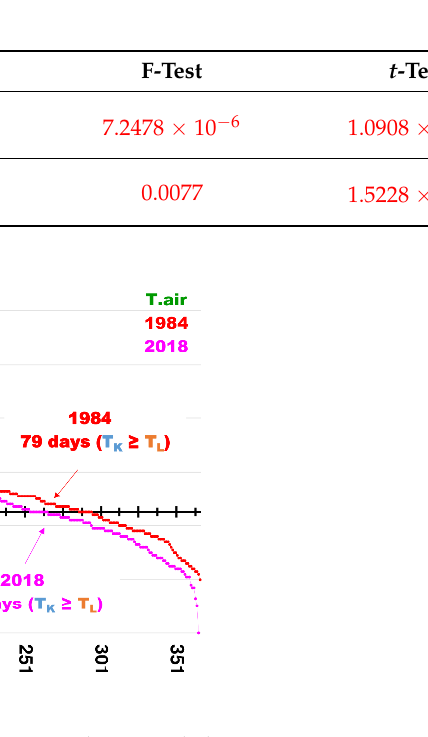
Figure 7. Duration curves of the differences between the mean daily air temperatures at Lastovo and Krk calculated for 1984 (red) and 2018 (purple).